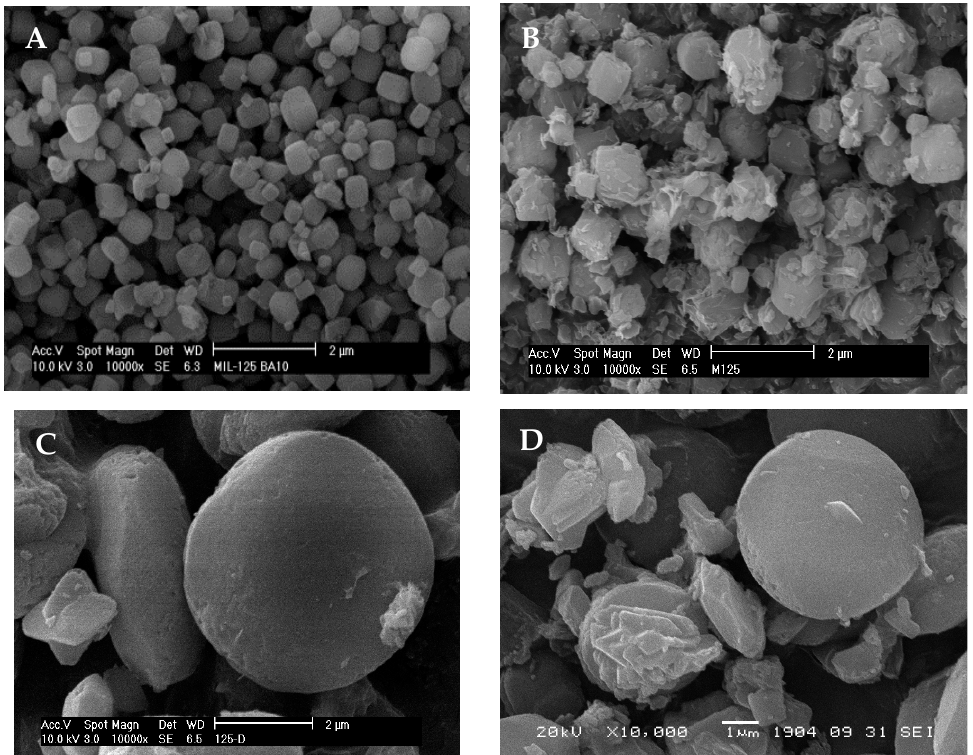
Figure 2. The SEM images of MIL-125 samples: ( A ) MIL-125-S, ( B ) MIL-125-M, ( C ) MIL-125-L, and ( D ) MIL-125-L after catalysis (reaction conditions as in Table 2, entry 10).